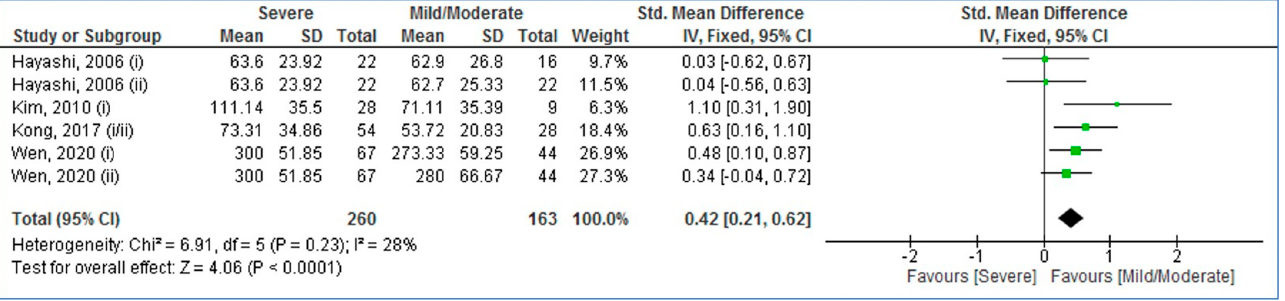
Table 2. Subgroup analysis in adults with obstructive sleep apnea compared to controls. Variable, N SMD